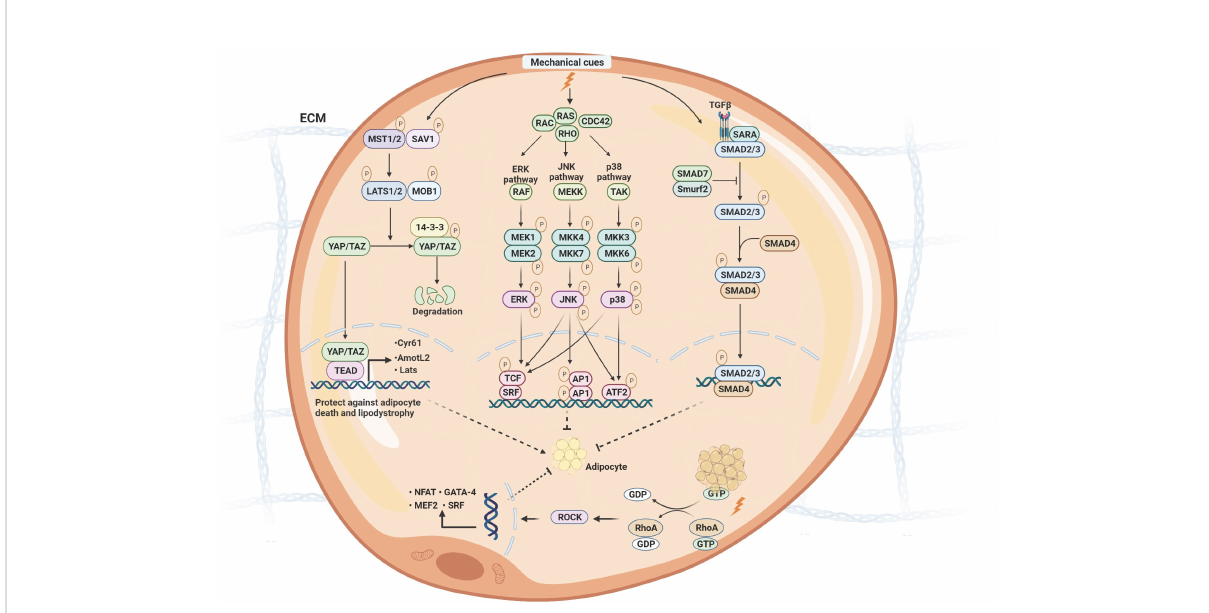
FIGURE 3 The molecular signaling of mechanotransduction in adipocytes. The molecular signaling of mechanotransduction in adipocytes includes focal adhesion kinase (YAP)/transcriptional coactivator with PDZ ‐ binding motif (TAZ), Mitogen-activated protein kinases (MAPK)/extracellular signal- regulated kinases (ERK), Ras Homolog Family Member A/Rho-Associated Protein Kinase (RhoA/ROCK), and transforming growth factor b 1 (TGF- b 1)/Smad signaling pathway. Moreover, mechanical stimuli mediate adipose differentiation. YAP/TAZ signaling pathway enhances adipogenesis; MAPK/ERK, RhoA/ROCK, and TGF- b 1/Smad signaling pathway inhibit adipogenesis. ECM, extracellular matrix; Mst, mammalian ste20-like protein kinase; LATS1/2, large tumor suppressor 1 and 2; MOB1, MOB kinase activator 1; SAV1, Sav family containing protein 1; YAP/TAZ, yes-associated protein)/transcriptional co-activator with PDZ binding motif; TEAD, members of the TEA domain; CDC42, Cell division control protein 42; ERK, extracellular signal-regulated kinase;MEKK, MAP kinase kinase kinase; TAK, TGF b -activated kinase; MKK, MAP kinase kinase; JNK, c-Jun N- terminal protein kinases; TCF, ternary complex factor; SRF, serum response factor; AP1, Activator protein 1; ATF2, Activating transcription factor 2; TGF, transforming growth factor b ; SARA, Smad anchor for receptor activation; Smurf2, Smad ubiquitin regulatory factor 2; GTP, guanosine triphosphate; GDP, guanosine diphosphate; RhoA, Ras Homolog Family Member A; ROCK, Rho-Associated Protein